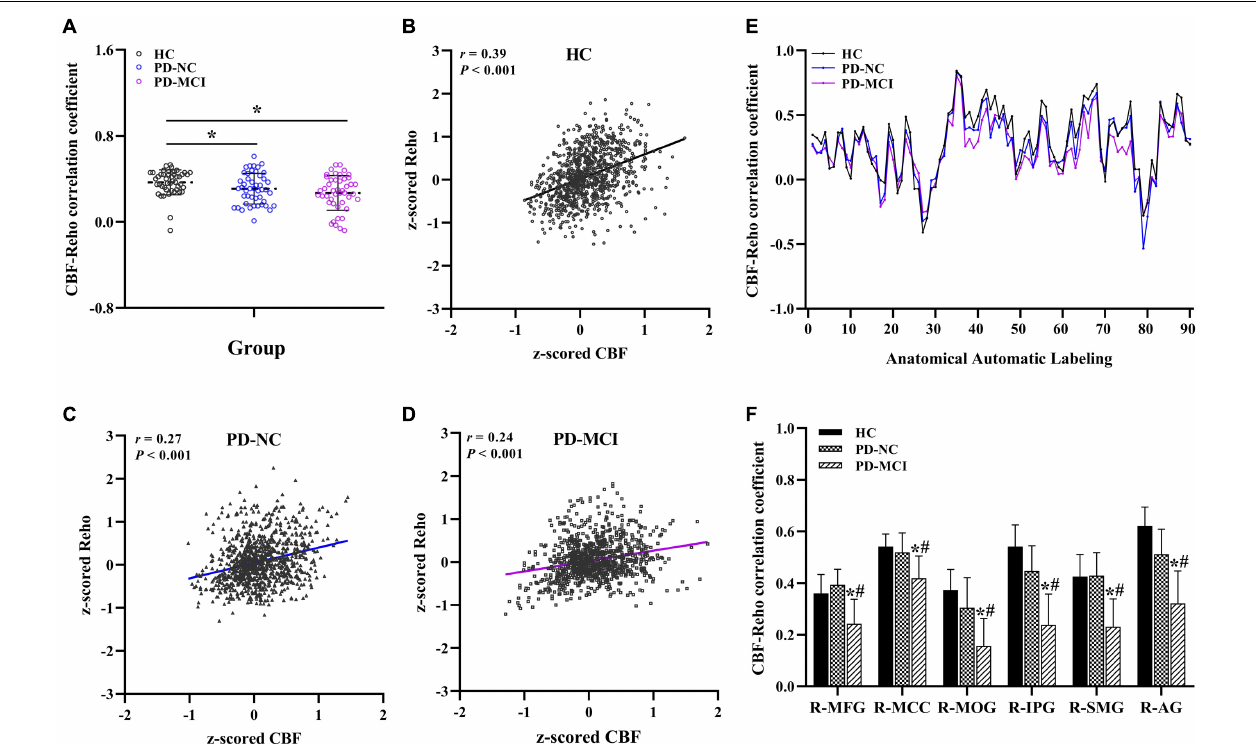
FIGURE 1 | Global and regional neurovascular coupling among groups. The mean CBF-ReHo coupling at the global level among groups (A) and representative scatter plots of the spatial correlations across voxels in individuals (B–D) ; regional neurovascular coupling of CBF-ReHo (E) and the significantly different brain regions in the PD-MCI group as compared with HC and PD-NC groups (F) . *Indicates significant intergroup difference to HC group; # indicates significant intergroup difference to PD-NC group. CBF, cerebral blood flow; ReHo, regional homogeneity; HC, healthy control; PD, Parkinson’s disease; NC, normal cognition; MCI, mild cognitive impairment; R, right; L, left; MFG, middle frontal gyrus; MCC, middle cingulate cortex; MOG, middle occipital gyrus; IPG, inferior parietal gyrus; SMG, supramarginal gyrus; AG, angular